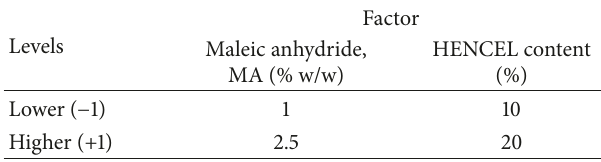
Table 1: Levels of factors in the experimental